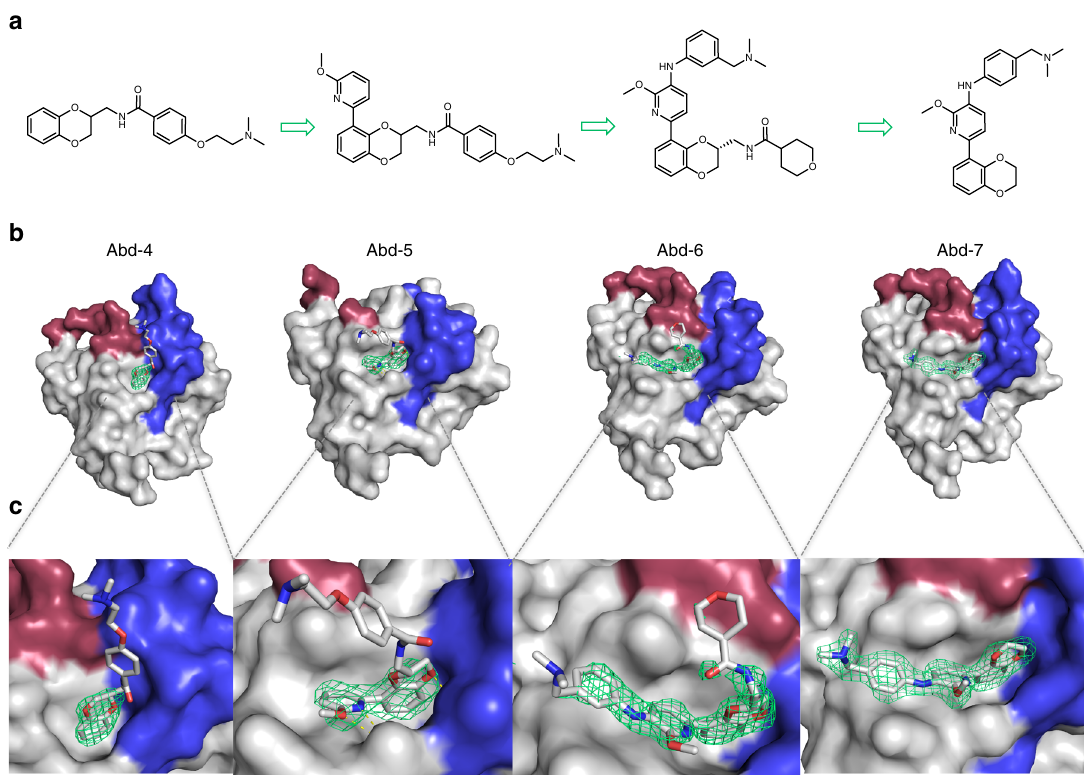
Fig. 3 RAS-binding series development from antibody-derived initial hit. Representative examples of KRAS-binding compounds Abd-4 to Abd-7 guided by structural biology information. a Chemical structures of the chemical series with numbering on different rings. b Crystal structures with the mode of binding of each compound to KRAS Q61H -GppNHp (shown in grey) in the pocket close to the switch regions I (red) and II (blue). Each new analogue has extended its interaction with the protein, reaching to parts of the switch I region. c Expanded view to the compounds binding to KRAS, with the electron density identi fi ed in the crystallographic experiments depicted as a green mesh ( 2mFo-DFc maps contoured at 1.0